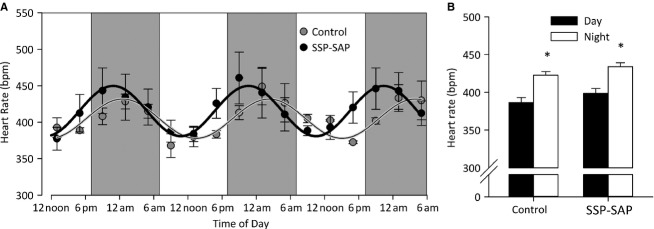
Daily variation in heart rate in SAP‐SSP lesioned rats. (A) Circadian variation in heart rate was plotted as average heart rate per 4 h in both control and SSP‐SAP‐lesioned rats. These data were fit with a standard sigmoidal waveform and a significant shift in the circadian phase from 3.28 ± 0.16 to 4.49 ± 0.20 radians was observed (P < 0.05 Student's paired t‐test). (B) Control and lesioned rats both show increased heart rate at night compared to during the day; from 387 ± 6 to 423 ± 5 beats min−1 in control (n = 3; P < 0.001 by one‐way ANOVA) and 399 ± 6 to 436 ± 5 beats min−1 in lesioned rats (n = 3; P < 0.001 by one‐way ANOVA). No differences between the two groups were observed.